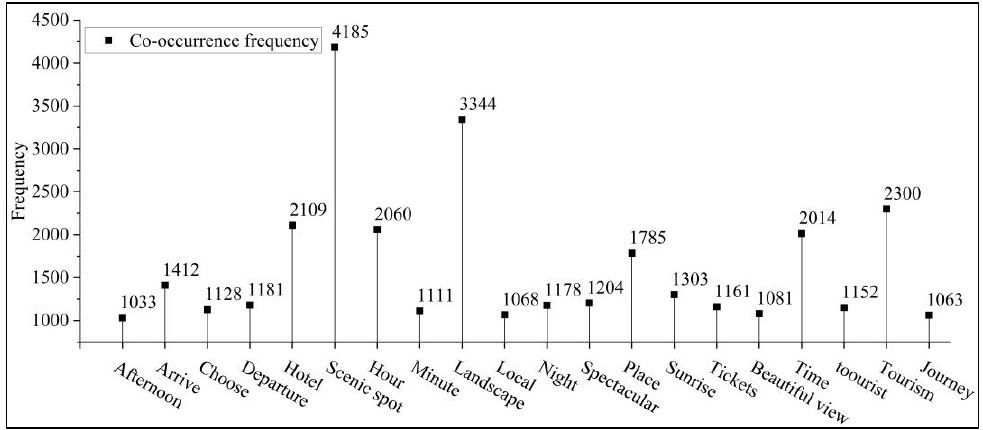
Figure 3. Top 20 words that co- occur with “terraced fields” .